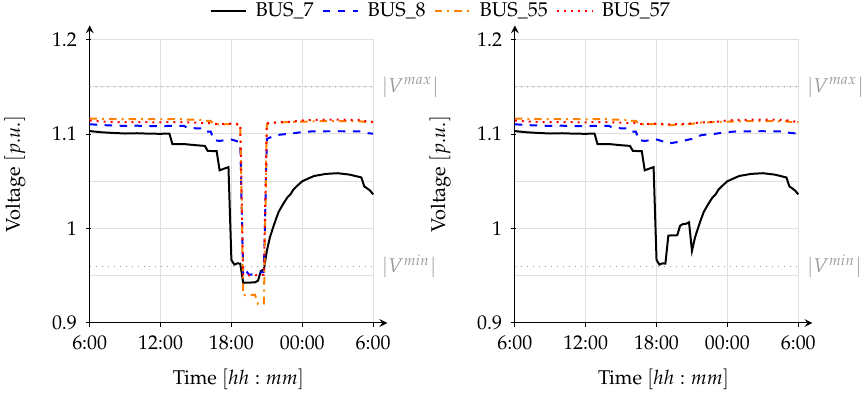
Figure 16. Time evolution of bus voltages before load shedding ( left ) and after ( right ) for scenario 2. Load shedding was applied at 15 buses. Among these buses are the 4 buses from scenario 1, which are shown in this